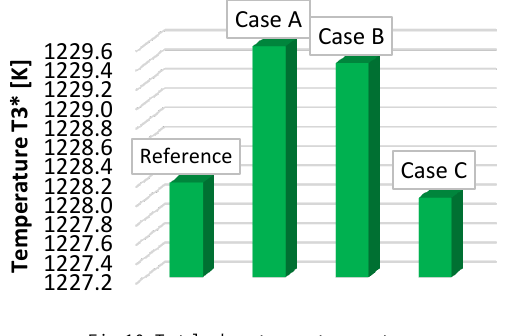
Fig. 10. Total exhaust gases temperature